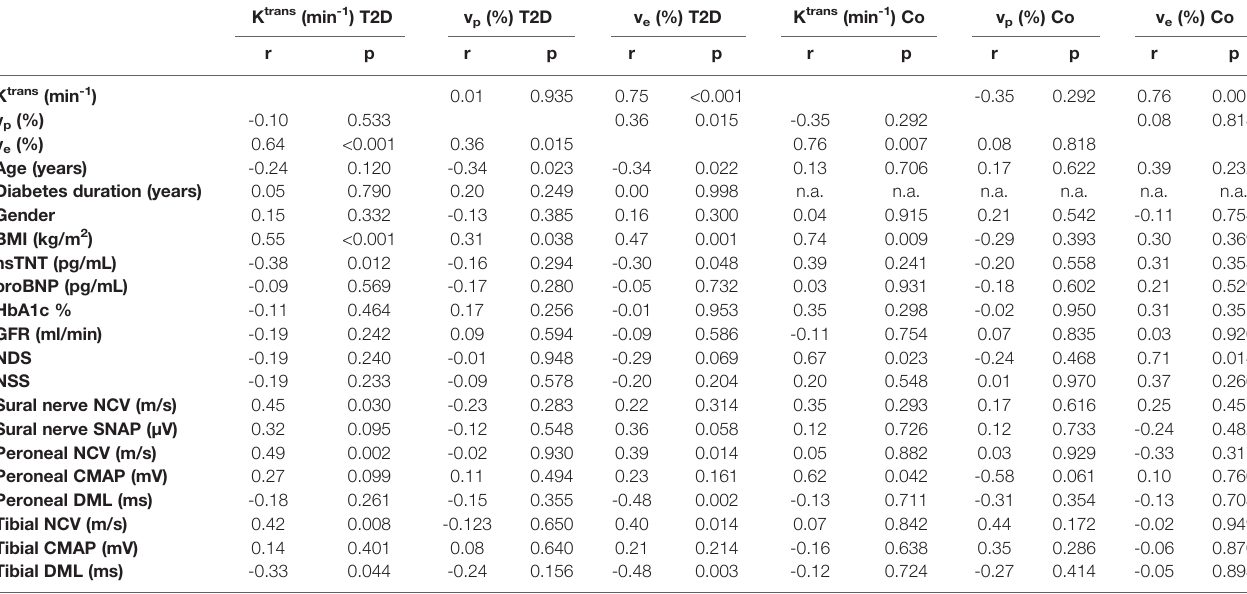
TABLE 3 | Correlations of MRN perfusion parameters with demographic, serological, clinical, and electrophysiological data. K trans (min -1 ) T2D